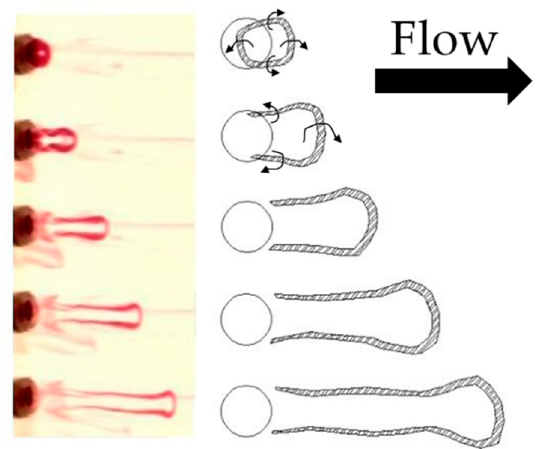
Figure 5. Development of hairpin vortex from vortex ring issued through test plate in cross flow. Arrows indicate vorticity distributions around the hairpin vortex.